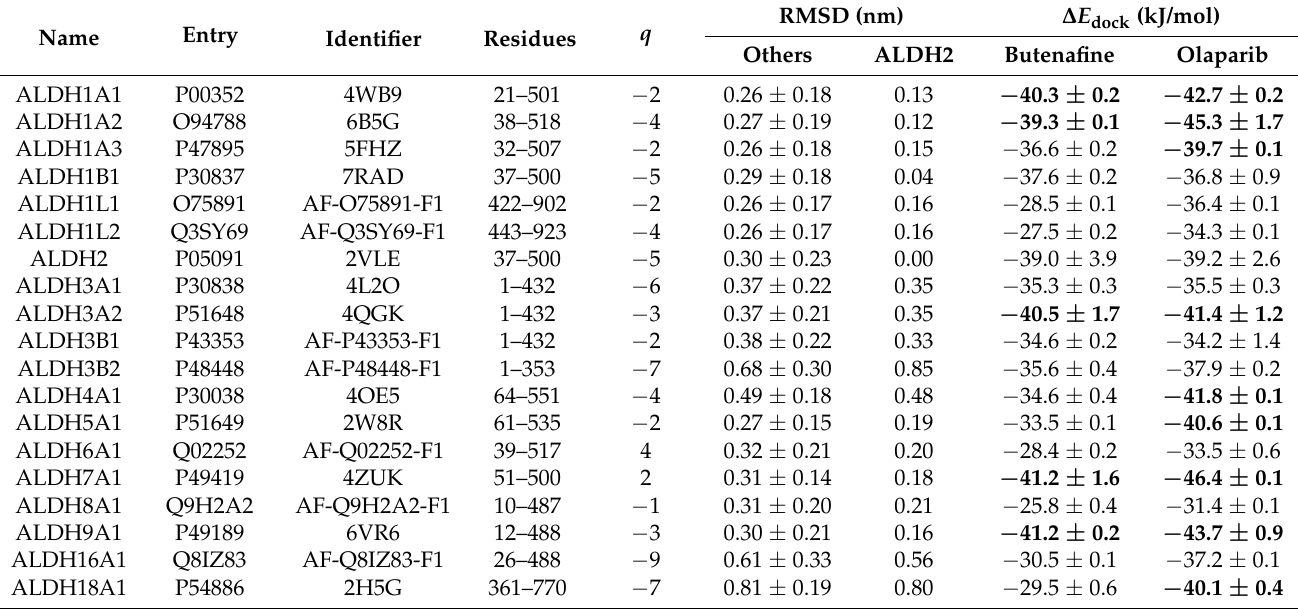
Table 5. Structural comparison of 19 NAD(P) + -dependent members in the hum an ALDH family and their binding affinities with butenafine and olaparib from docking